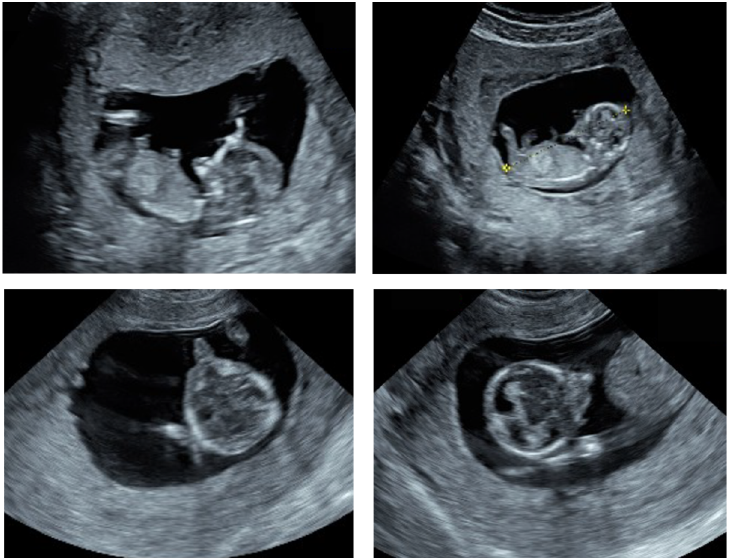
Figure 1. Ultrasound findings of the fetus at 11 weeks gestation. Sagittal sections ( top two images ) showing the absence of the mandible and the axial sections ( lower two images ) showing the asym- metry of the maxillary bones and a protruding tubular structure (proboscis) from the lower part of the face.